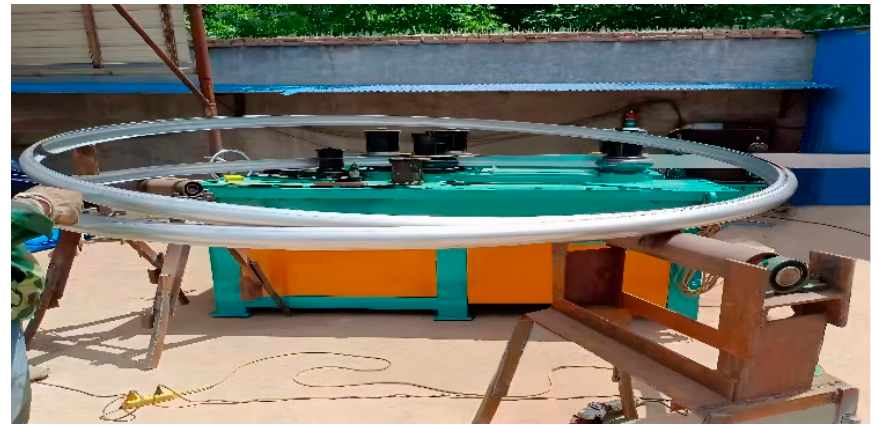
Figure 1. Manufacture of helical half-pipe jackets.